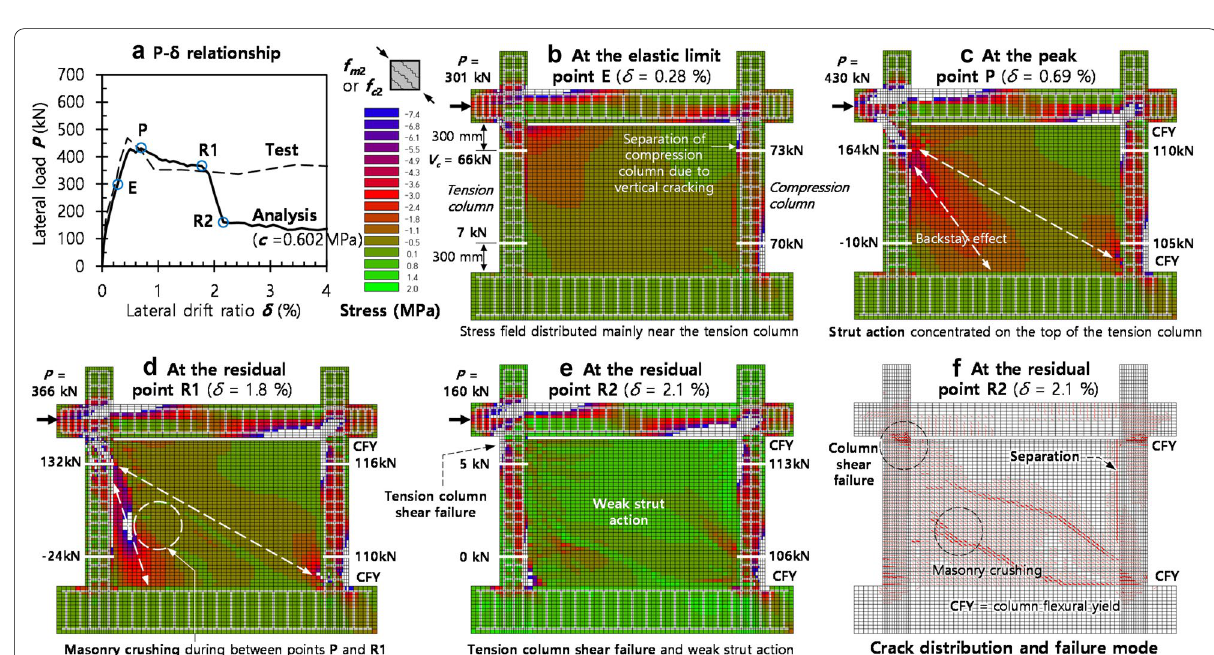
Fig. 9 Variation of stress distribution and force transfer with deformation: substandard infilled frame IFS1.0–strong masonry